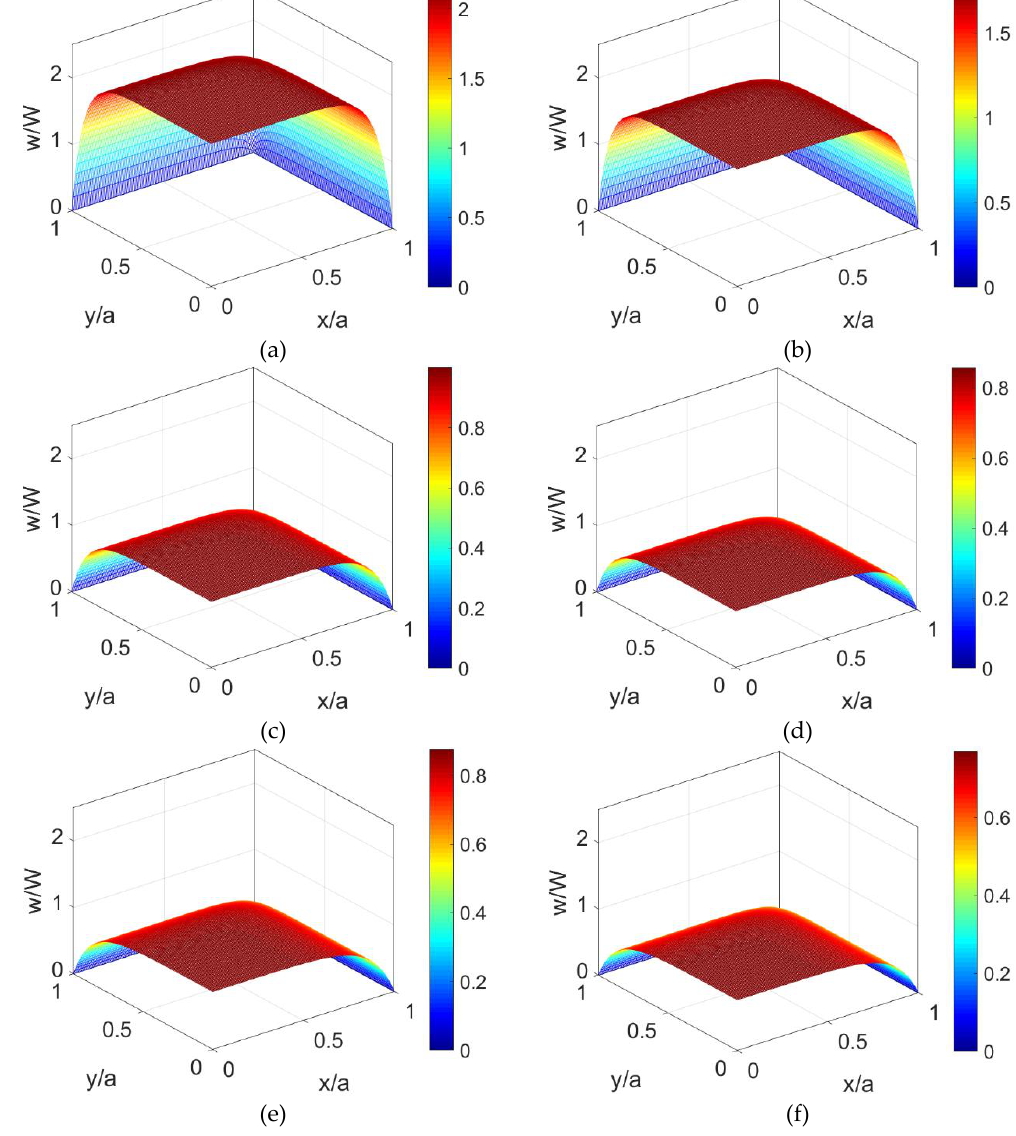
Figure 3. The comparison among the velocity distributions of shear thinning nanofluid, Newtonian nanofluid and shear thickening nanofluid at di ff erent nanoparticle volume fraction: ( a ) φ = 0, n = 0.8; ( b ) φ = 0.06, n = 0.8; ( c ) φ = 0, n = 1.0; ( d ) φ = 0.06, n = 1.0; ( e ) φ = 0, n = 1.2; ( f ) φ = 0.06, n =